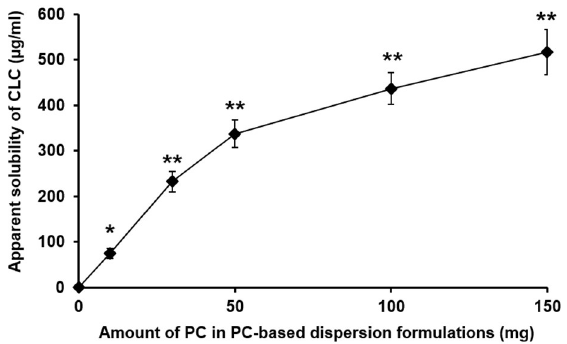
Figure 1. Apparent aqueous solubility of CLC incorporated in PC-based dispersion formulations prepared with different amounts of PC and the drug of 100 mg. The values are mean ± SD ( n = 3). Single and double asterisks indicate the statistical differences at P < 0.001 and P < 0.0001, respectively, in comparison to the solubility of CLC alone.